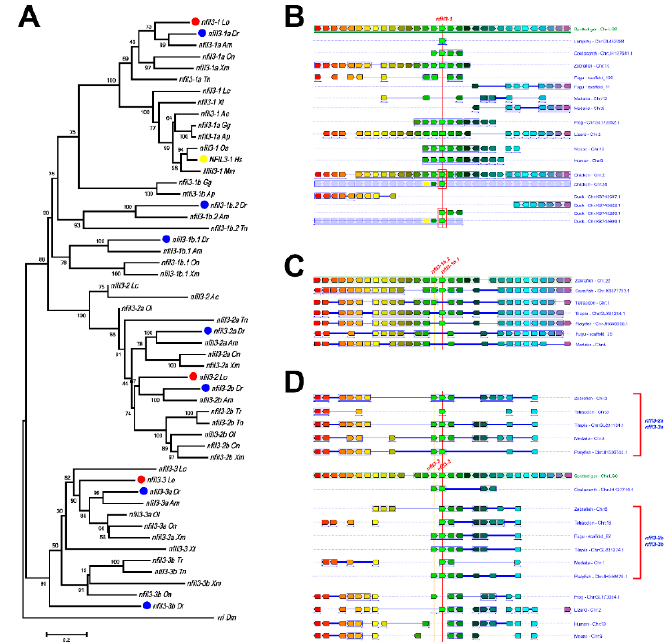
Figure 2. The phylogenetic and conserved syntenic analyses of the nfil3 family. ( A ) Phylogenetic trees based on sequences of nfil3 genes. The tree was constructed by the neighbor-joining method with MEGA6 [33], and the numbers on the nodes are the percent bootstrap values based on 1000 pseudoreplications. The outgroup is fly vri . Red dots indicate spotted gar genes, blue dots indicate zebrafish genes, and yellow dots indicate human genes. ( B ) The conserved synteny surrounding nfil3-1 genes in the chromosomes of lampreys, coelacanths, spotted gar, zebrafish, medaka, fugu, frogs, lizards, chickens, ducks, mice and humans was displayed with Genomicus [35]. ( C ) The conserved synteny of nfil3-1b.1 and nfil3-1b.2 genes in the chromosomes of zebrafish, cave fish, tilapia, platyfish, medaka, tilapia, and fugu. ( D ) Conserved synteny of nfil3-2 and nfil3-3 genes in chromosomes of coelacanth, spotted gar, zebrafish, medaka, teraodon, fugu, tilapia, platyfish, frogs, lizards, mice, and humans. The chromosome number or linkage group number is shown to the right of the chromosomes. The same colored rectangles represent the orthologous genes. Red and blue boxes indicate the duplicated genes.